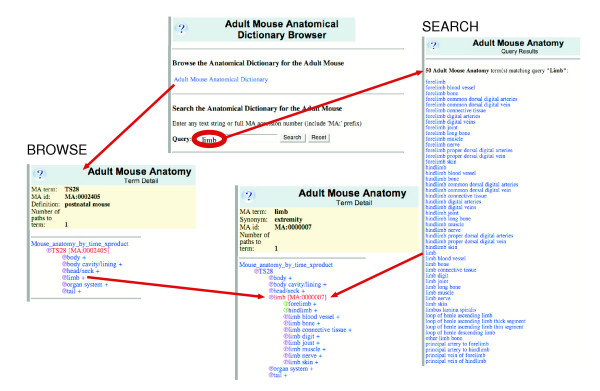
Using the Adult Mouse Anatomical Dictionary Browser. The MGI Browser allows the user to either browse (progressively navigate through the various hierarchies) or search (enter a text string to query for terms, for example limb) within the adult mouse anatomy ontology. 'Term Detail' pages include the unique numerical identifiers (that is MA ID numbers) for each term, as well as relevant definitions and/or synonyms.